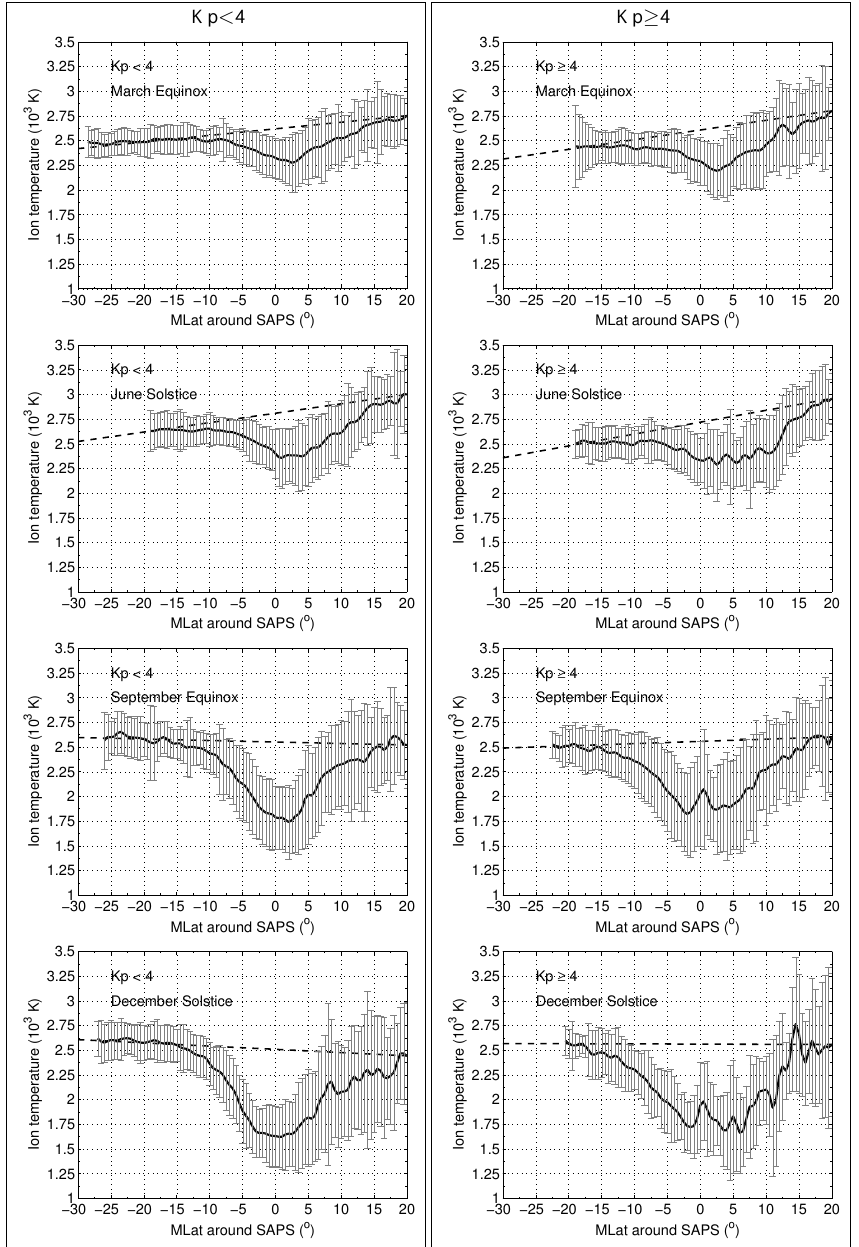
Fig. 5. The same as Figure 2, but for ion temperature. The background trend is indicated by a dashed line.